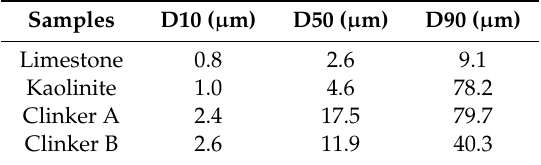
Table 3. Median particle sizes: D10%, D50% and D90% of raw limestone, raw kaolinite, clinker A and clinker B powders.